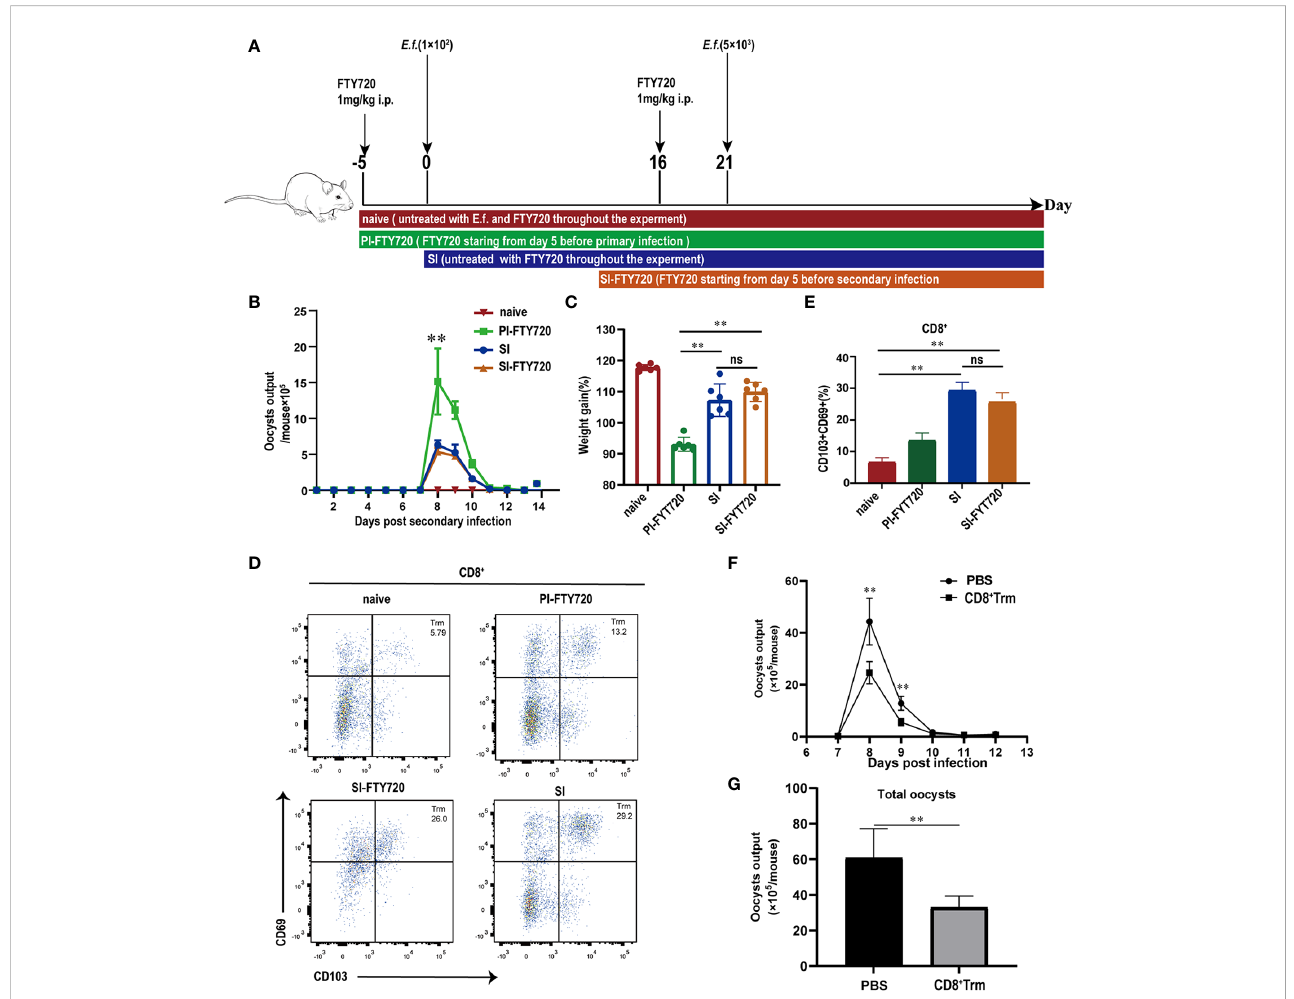
FIGURE 5 CD8 + Trm cells were responsible for protection against E. falciformis infection. (A) Experimental design for treatment with FTY720 scheme. Mice were given FTY720 by intraperitoneal injection for 5 d before primary or secondary infection and during infection with E. falciformis . (B) Kinetics of oocyst output of mice treated or untreated with FTY720 at 6-13 days post reinfection with 5000 E. falciformis . n =6 per treatment group. (C) Body weight change of mice treated or untreated with FTY720 at 8 days post reinfection with 5000 E. falciformis . n =6 per treatment group. (D) Representative fl ow cytometric plots for expression of CD69 and CD103 on CD8 + T-cells in LPL from mice treated or untreated with FTY720 at 24 hours post reinfection with 5000 E. falciformis . n =6 per treatment group. (E) Summary bar graph of CD8 + Trm, gated on live CD8 + cells. (F) Kinetics of oocyst output of mice received CD8 + Trm or PBS at 6-13 days post infection with 100 E.falciformis . n =5 per treatment group. (G) Total oocyst output of mice received CD8 + Trm or PBS. n =5 per treatment group. Results are mean ± SD from three independent experiments, ns, no statistical signi fi cance between treatment groups, ** p ≤ 0.01, PI, primary infection; SI, secondary